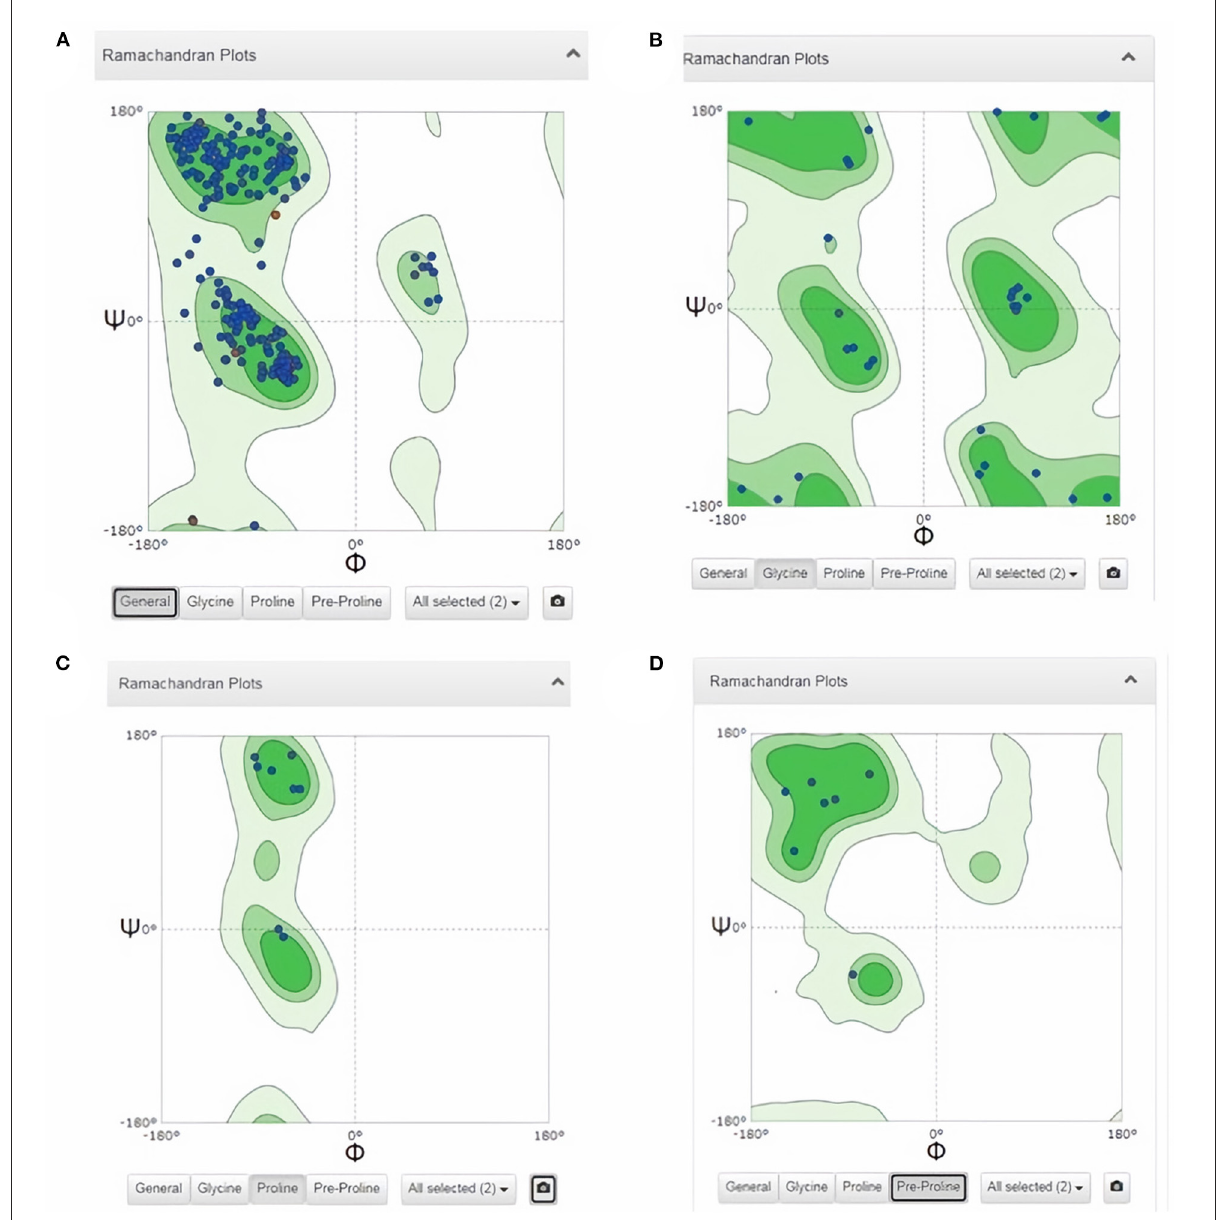
FIGURE3 Analysis of 3D model of FhCatL1 via Ramachandran plot from SWISS-MODEL server. The model demonstrated MolProbity (0.92), Clash score (0.21), Poor rotamers (1.0) and Ramachandran favored (95.78%), no Ramachandran outliers, C-Beta deviations or bad bonds, Rotamer outliers (1.16%), bad angels (30/6856) and twisted proline (2/18). (A) General plot, (B) Glycine based plot, (C) Proline based plot, (D) PreProline based plot (https://swissmodel.expasy.org/).